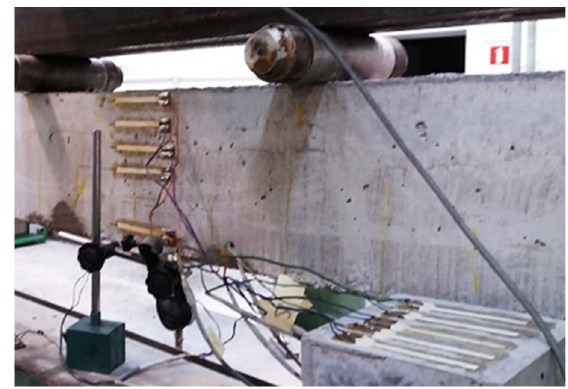
Figure 3. Strain gauge placement.